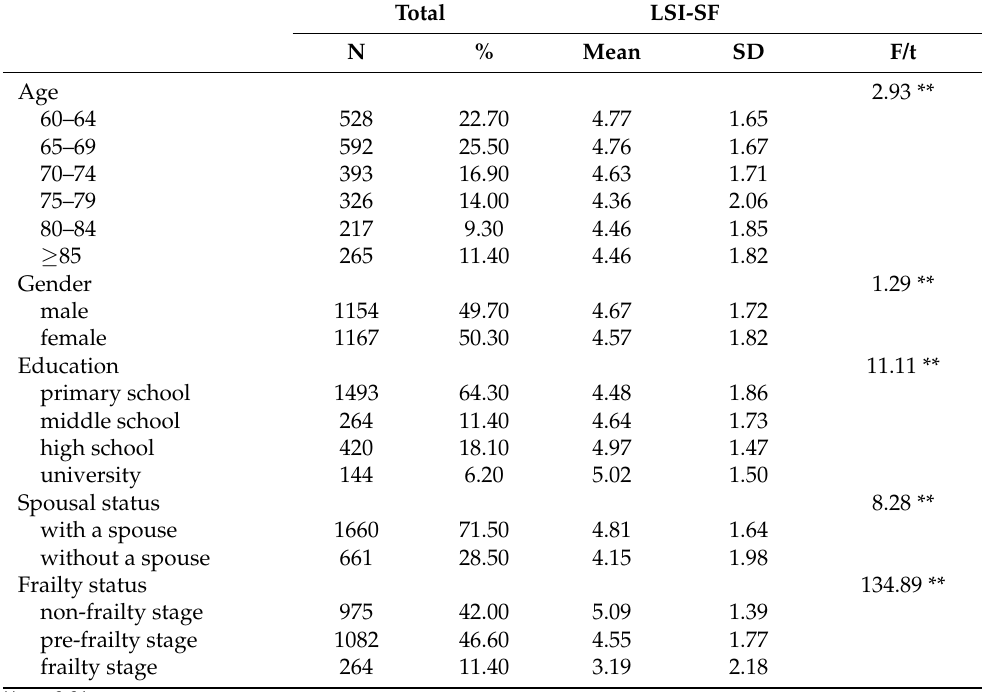
Table 2. Background characteristics and LSI-SF scores of the participants (N = 2321). Total LSI-SF N